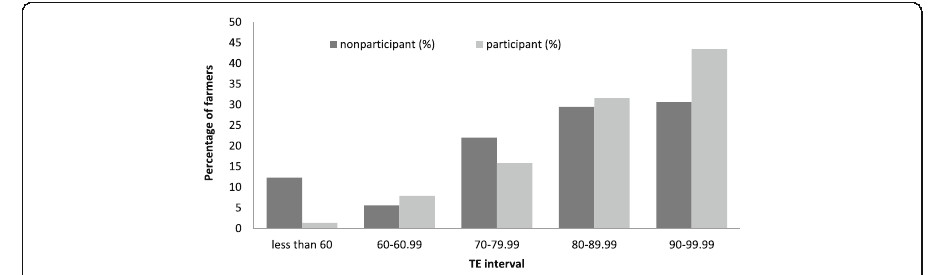
Fig. 2 The distribution of TE score for participant and non-participant farmers